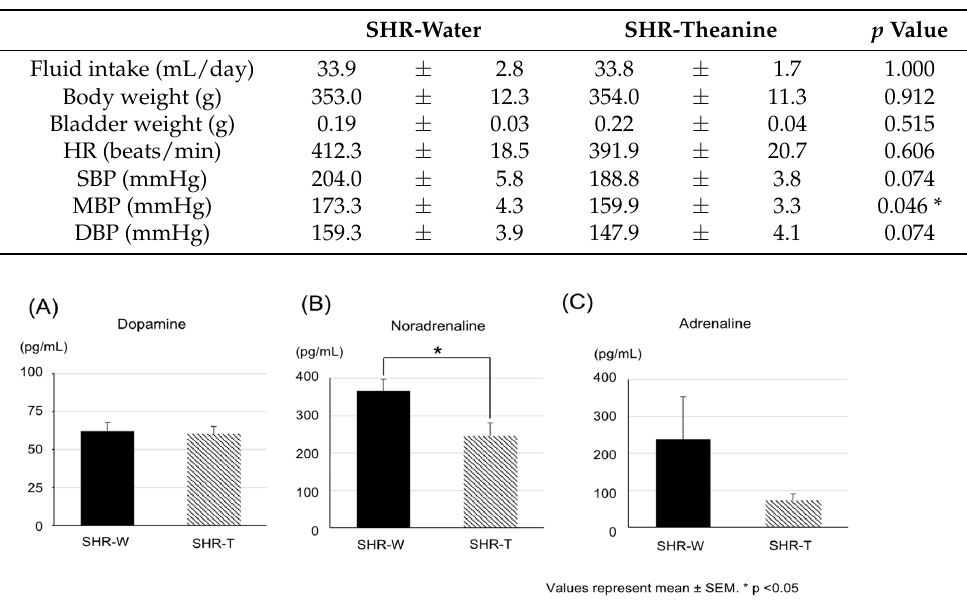
Table 1. General features of SHRs in the SHR–water and SHR–theanine groups. * Statistical signifi- cance at the p < 0.05 level.